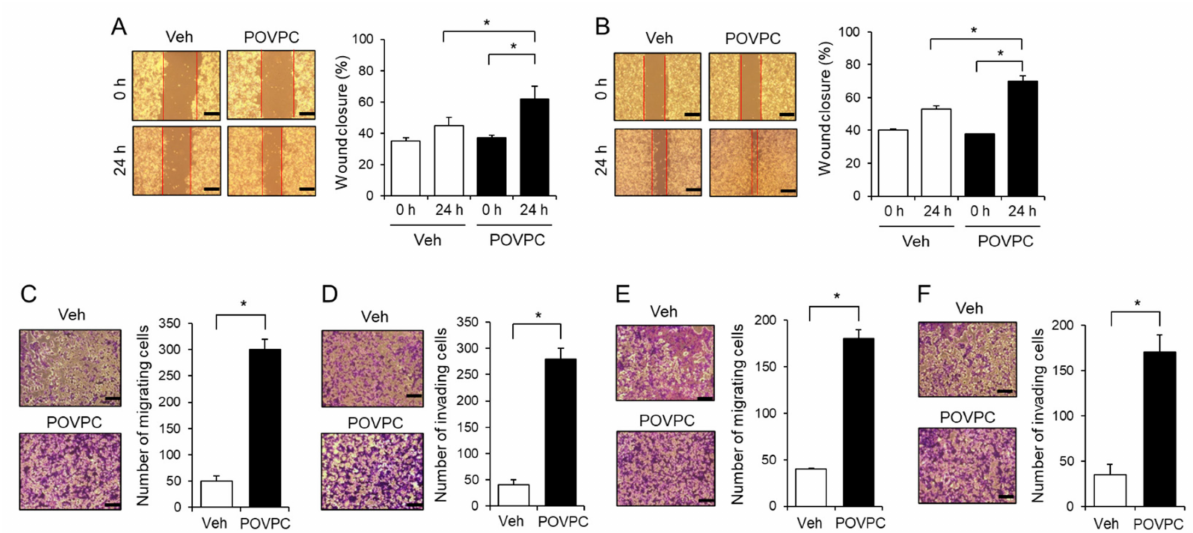
Figure 2. POVPC enhances the migration and invasion abilities of cancer cells. ( A ) HepG2 cells or ( B ) MCF7 cells were wounded with a single scratch in the presence of POVPC (5 µ g/mL) for 24 h. Wound closure was determined using customized ImageJ software, and the percentage of wound closure compared to unstimulated cells was calculated. The scale bar represents 100 µ m. ( C , D ) Migration or invasion of HepG2 cells was measured using a Transwell system after treatment with POVPC (5 µ g/mL) for 24 h. ( E , F ) Migration or invasion of MCF7 cells was measured using a Transwell system after treatment with POVPC (5 µ g/mL) for 24 h. Values in the line graphs represent the mean ± SEM ( n = 3). * p <